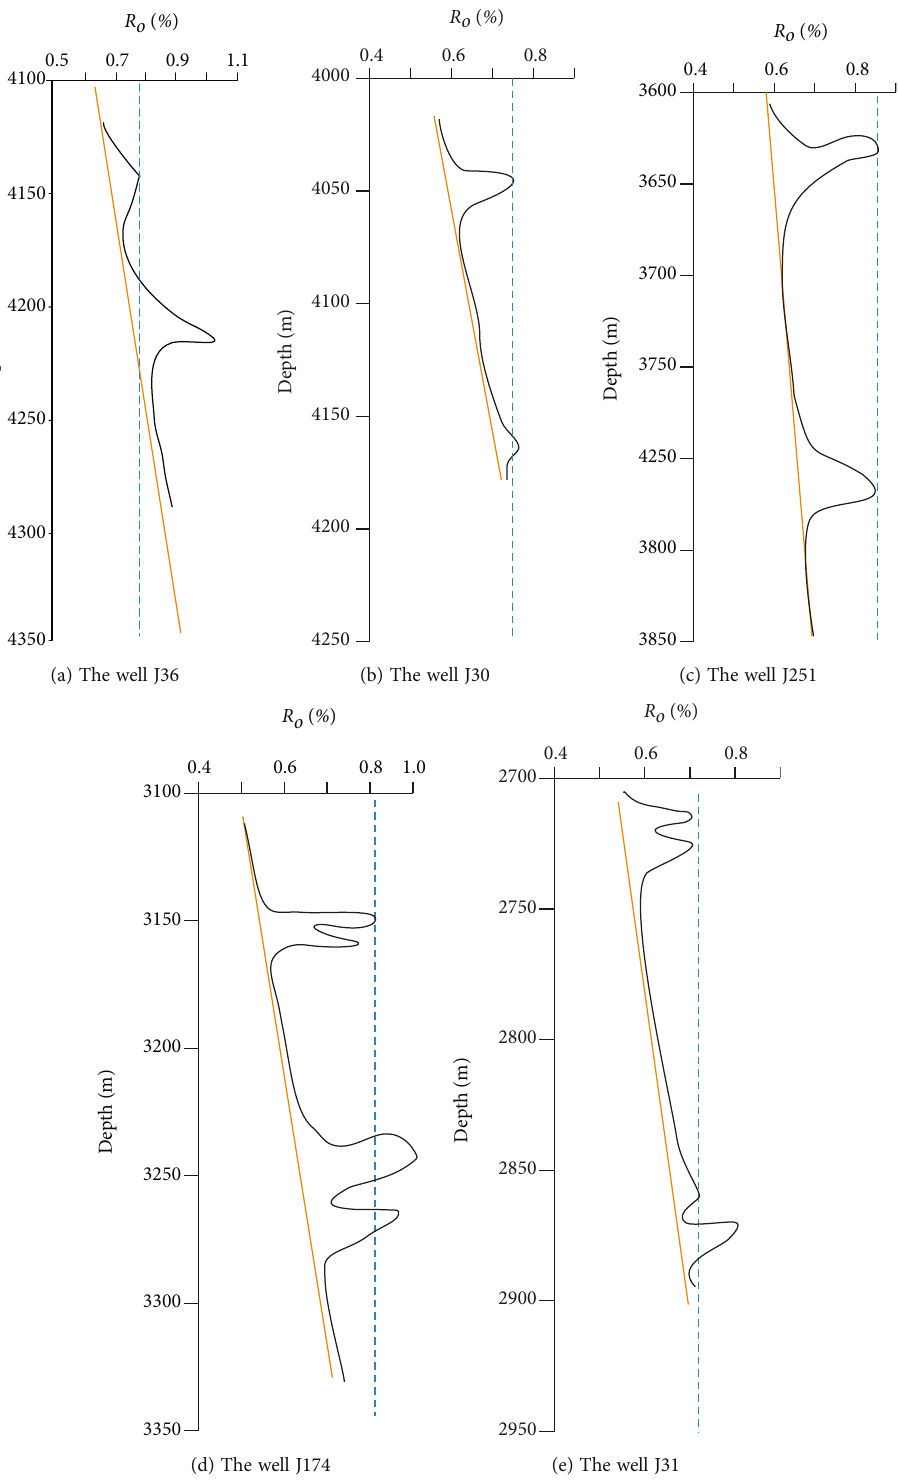
fi ed from Liu et al.,